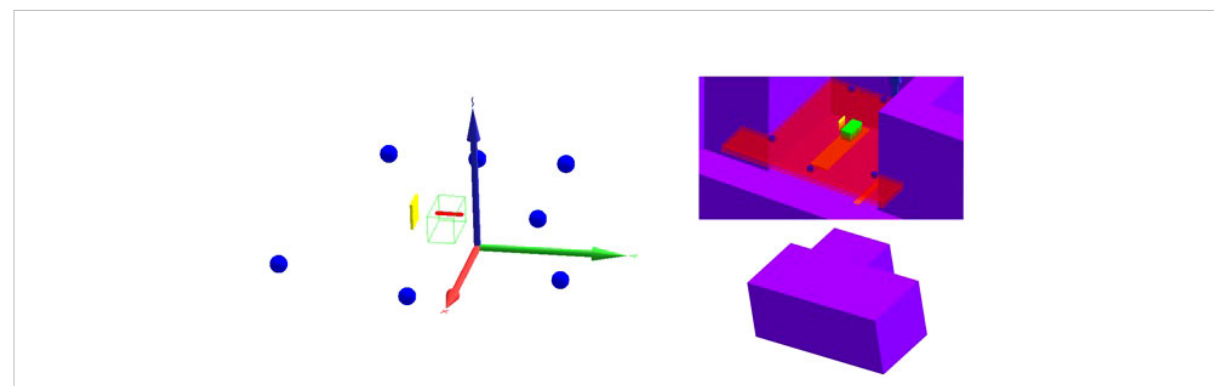
FIGURE 3 Geometrical models implemented in MCNP6.2. (Left) Model without room: solid water phantom (green), SOBP mesh tally (red), range shifter (yellow), and detectors (blue). (Right) Model with room with a view through the roof inside the room (top) and a view of the outside of the room (bottom): solid water phantom (green), positioning uncertainty mesh tally (red), range shifter (yellow), detectors (blue), table (orange), and walls, ceiling, and fl oor